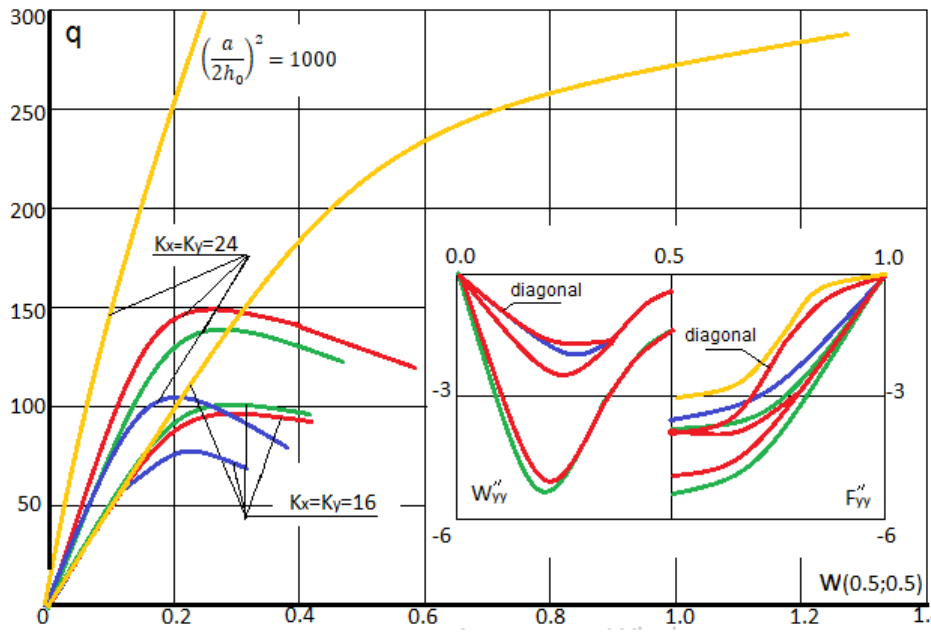
Figure 4. Load–deflection function in the shell center and shell cross-section I–I with regard to ∂ 2 F w (cid:48)(cid:48) yy = ∂ 2 w ∂ and F (cid:48)(cid:48) yy = ∂ y 2 . y 2